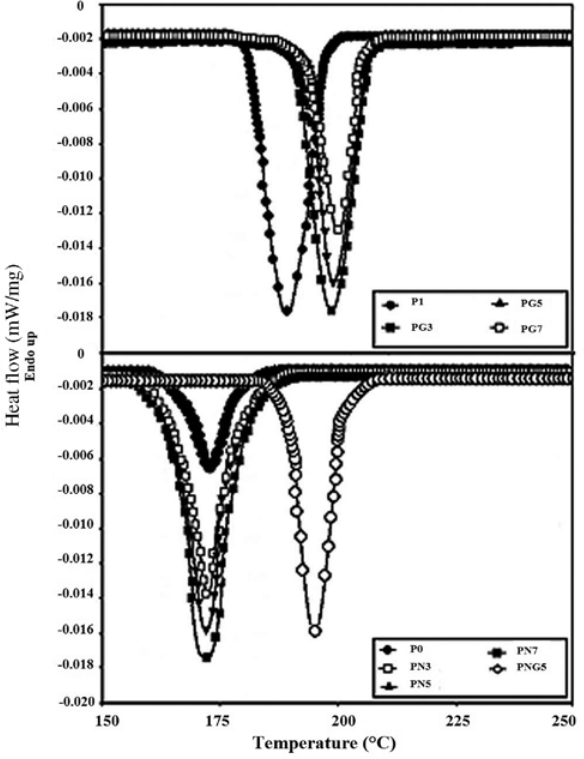
Figure 1: DSC thermograms of neat PA6 and PA6/PC/NBR blend with and without OC modifier and